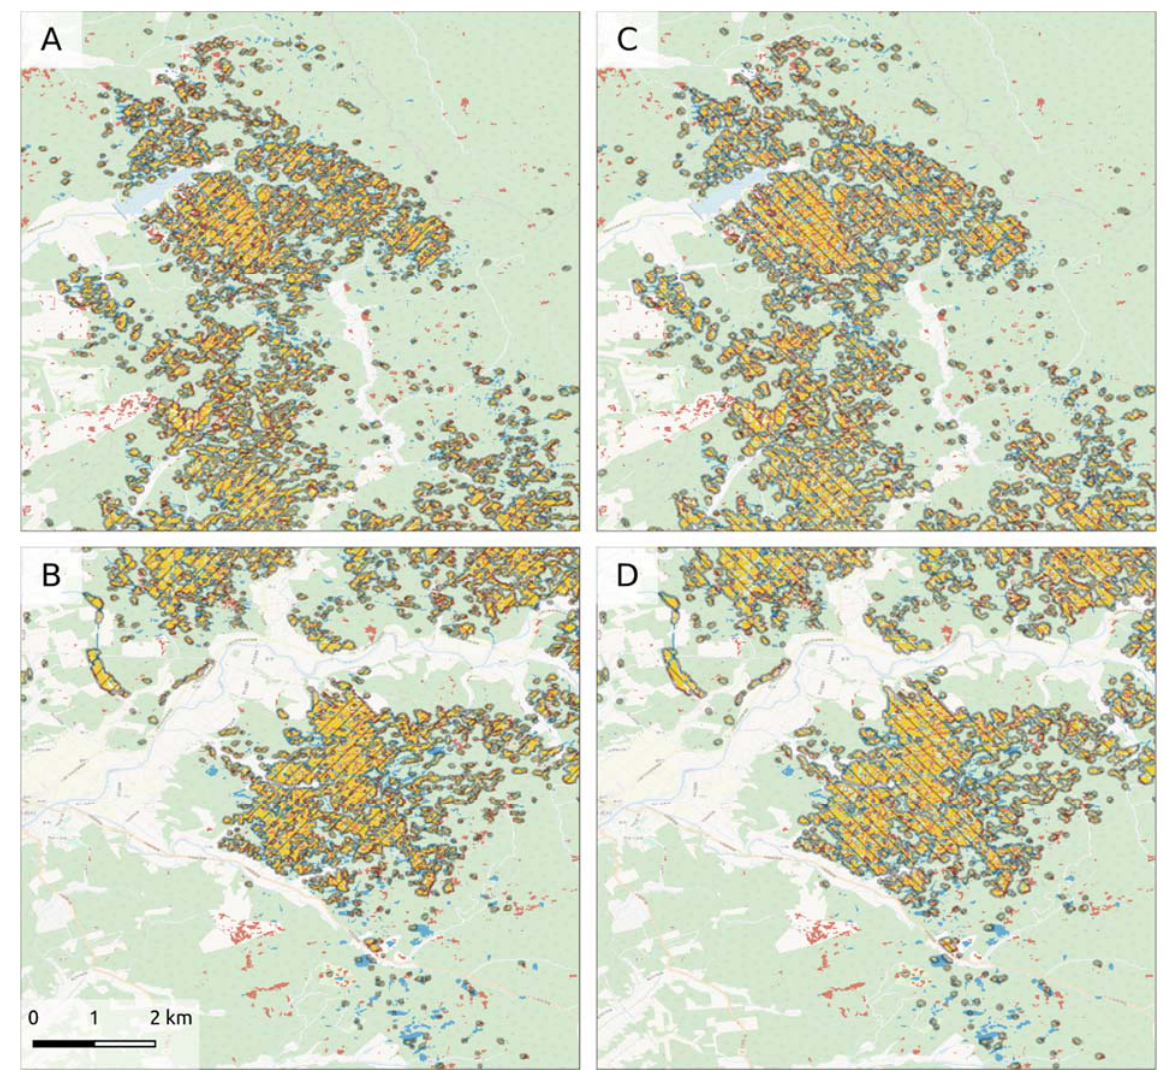
Figure 11. False negatives, false positives, and agreement of the classification results with the 30 m ( A , B ) and 45 m ( C , D ) buffer zone of the agreement. © OpenStreetMap contributors.